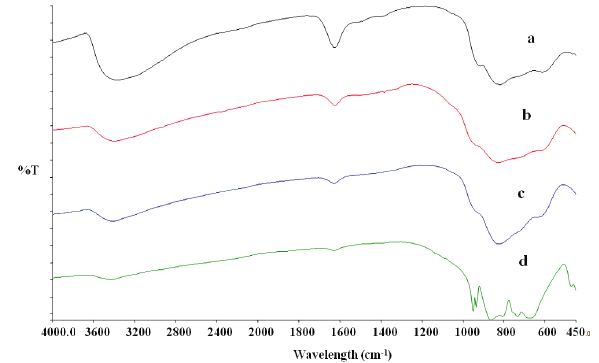
(WO ) nanoparticles prepared by the 2 4 3